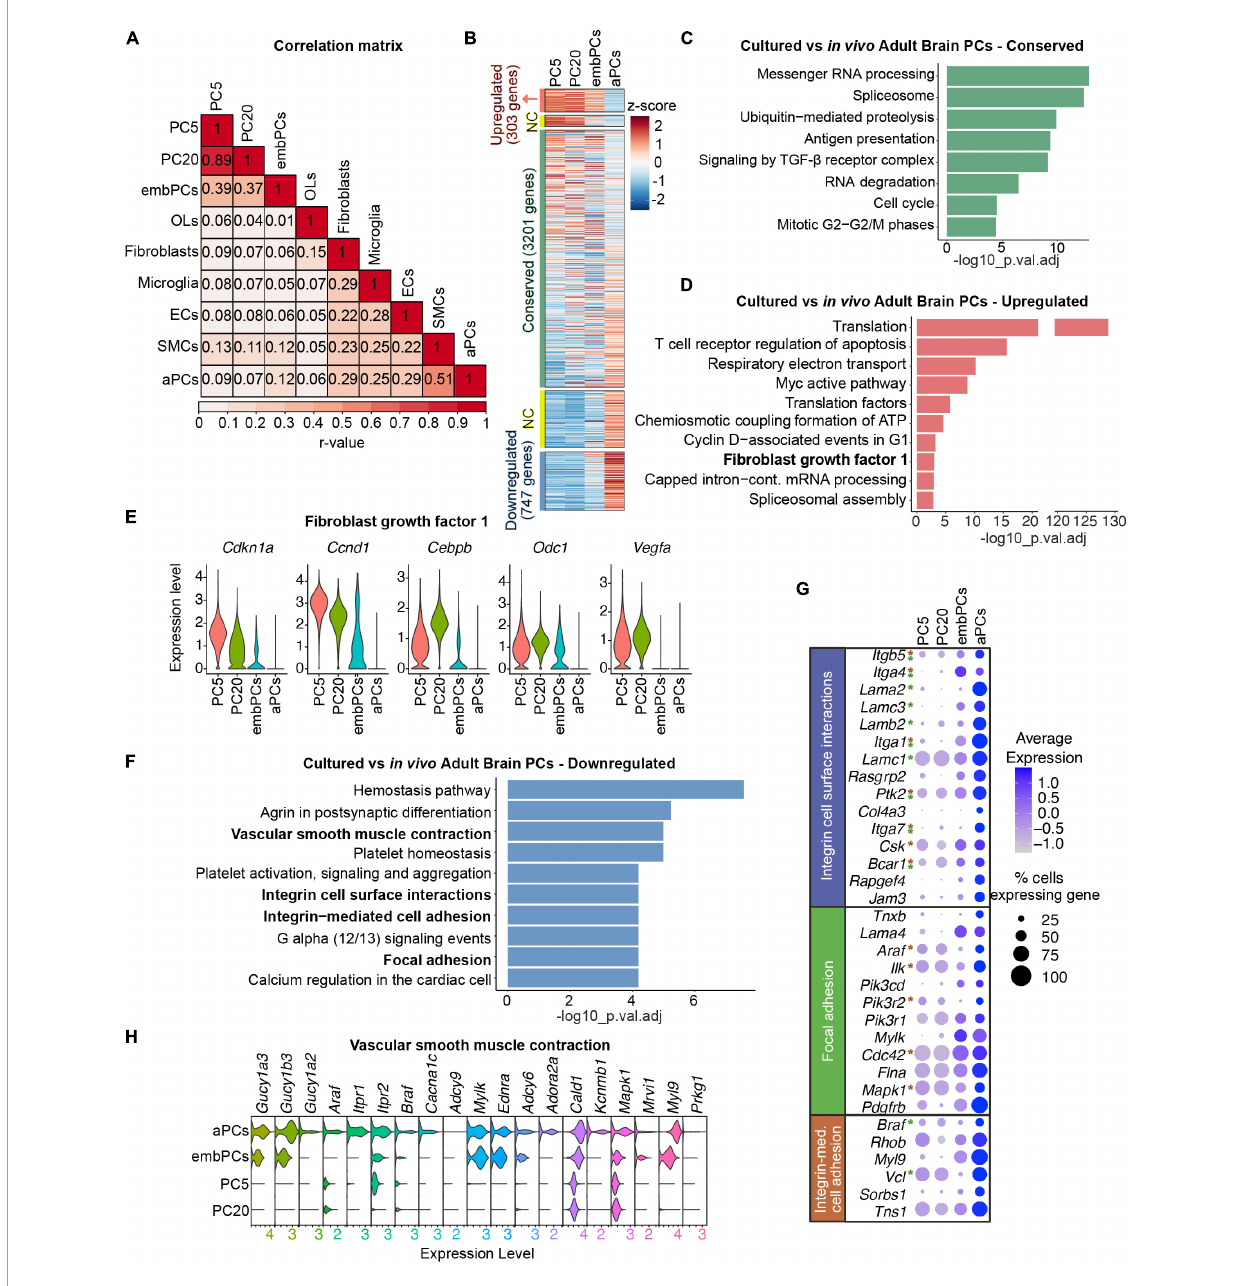
FIGURE2 Cultured PCs deregulate ECM genes. (A) Correlation of gene expression between the 9 main clusters. Numbers represent Pearson’s correlation ( r -value) (B) Heatmap representing the enrichment of gene expression in cultured, embryonic and adult PCs. Colors represent the average z-score for each gene. NC indicates genes not considered in the analysis, either 0.5 < log 2 FC < 1 or–1 < log 2 FC < –0.5. (C) BioPlanet annotated pathways conserved in cultured PCs vs. aPCs. (D) BioPlanet annotated pathways significantly upregulated in cultured PCs vs. aPCs. The highlighted FGF1 pathway is shown in more detail in (E) . (E) Violin plot representing the expression level of genes in the fibroblast growth factor 1 pathway in PC5, PC20, embPCs, and aPCs. (F) BioPlanet annotated pathways significantly downregulated in cultured PCs vs. aPCs. Pathways in bold are shown in more detail in (G,H) . (G) Dot plot representing the average expression of selected genes belonging to downregulated pathways in cultured PCs. Genes with asterisks are also part of other downregulated pathways, indicated by the colors (i.e., green for the focal adhesion pathway, and brown for the integrin-mediated cell adhesion). (H) Violin plot representing the expression level of genes in the vascular smooth muscle contraction pathway in PC5, PC20, embPCs, and aPCs. ECs, endothelial cells; NC, not considered; OLs, oligodendrocytes; PCs, pericytes; PC5, passage 5 pericytes; PC20, passage 20 pericytes; SMCs, smooth muscle